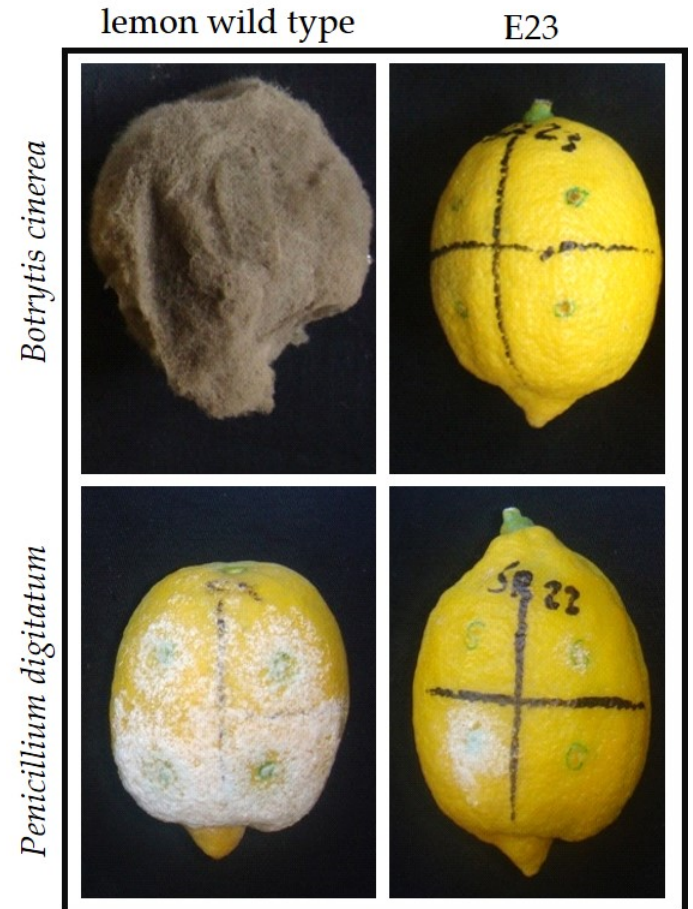
Figure 3. Disease symptoms in E23 transgenic lemon fruit compared to the wild type after inoculation with Botrytis cinerea (above) and Penicillium digitatum (below), after 14 and 6 days, respectively. Adapted from Oliveri et al. [62].